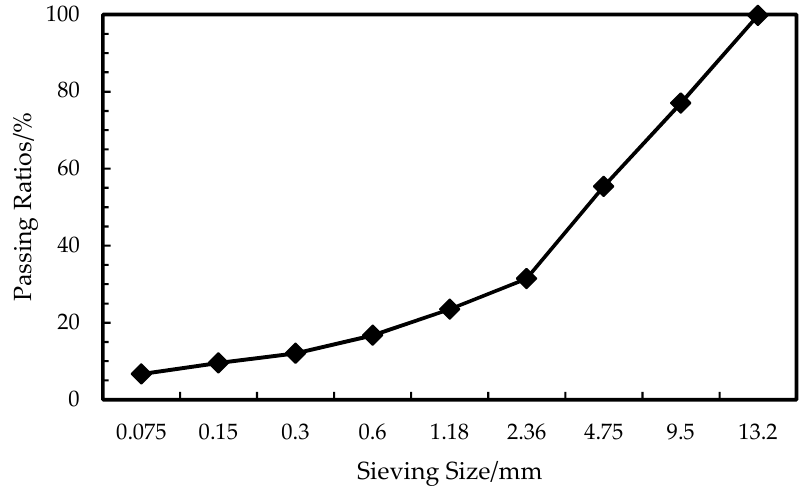
Figure 2. Aggregate gradation of the asphalt mixture.